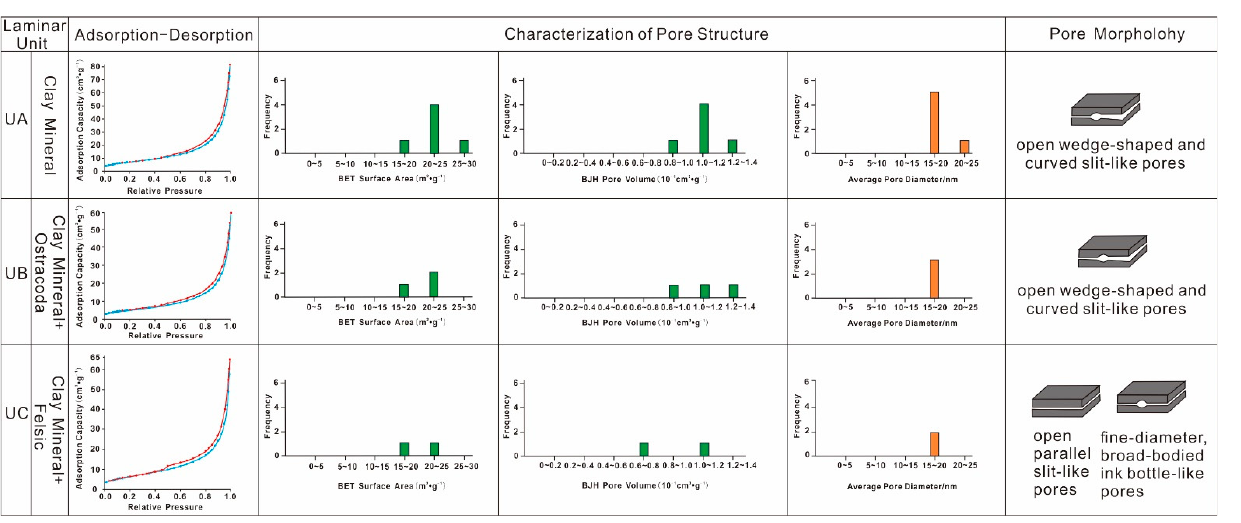
Figure 6. Characterization of the pore structure of nitrogen adsorption.